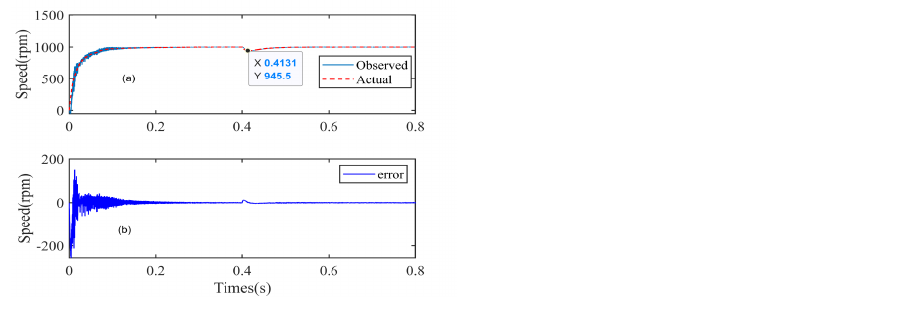
Figure A6. The speed response of VPDPI regulator when J = 0.0012 R s = 0.011. ( a ) Observed speed and actual speed. ( b ) Estimation error curve According to the test results of the appeal, it can be seen that when the parameters fluc- tuate, the adjustment performance of the proposed VPDPI regulator changes little, which ensures that the system without position sensor can still run stably when the parameters change, and further verifies the robustness of the proposed